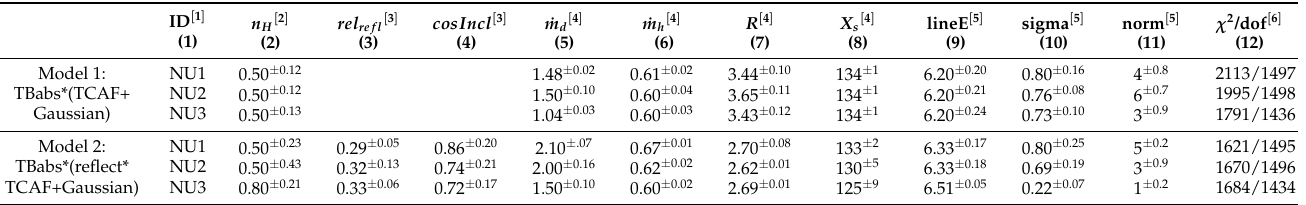
Table 4. Fitted parameters for NuSTAR data with TCAF/ REFLECT *TCAF model along with a Gaussian line (mass, M BH , is frozen at 9.1 M (cid:12) for TCAF